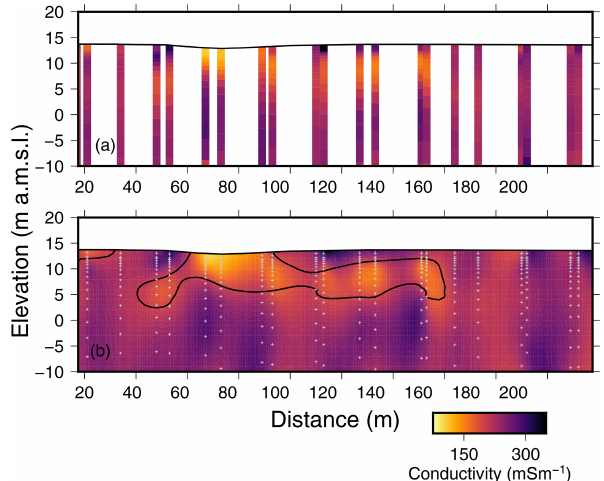
Figure 3. Electrical conductivity results produced by the NanoTEM soundings. The x axis is distance from the first geophone (Fig. 1). Both panels are shown at 2 × vertical exaggeration. (a) One- dimensional conductivity profiles plotted at their inverted resolu- tions as well as their spatial locations. (b) The interpolated conduc- tivity section. The black contour represents 200mSm − 1 . The small grey plus symbols represent the data used for the